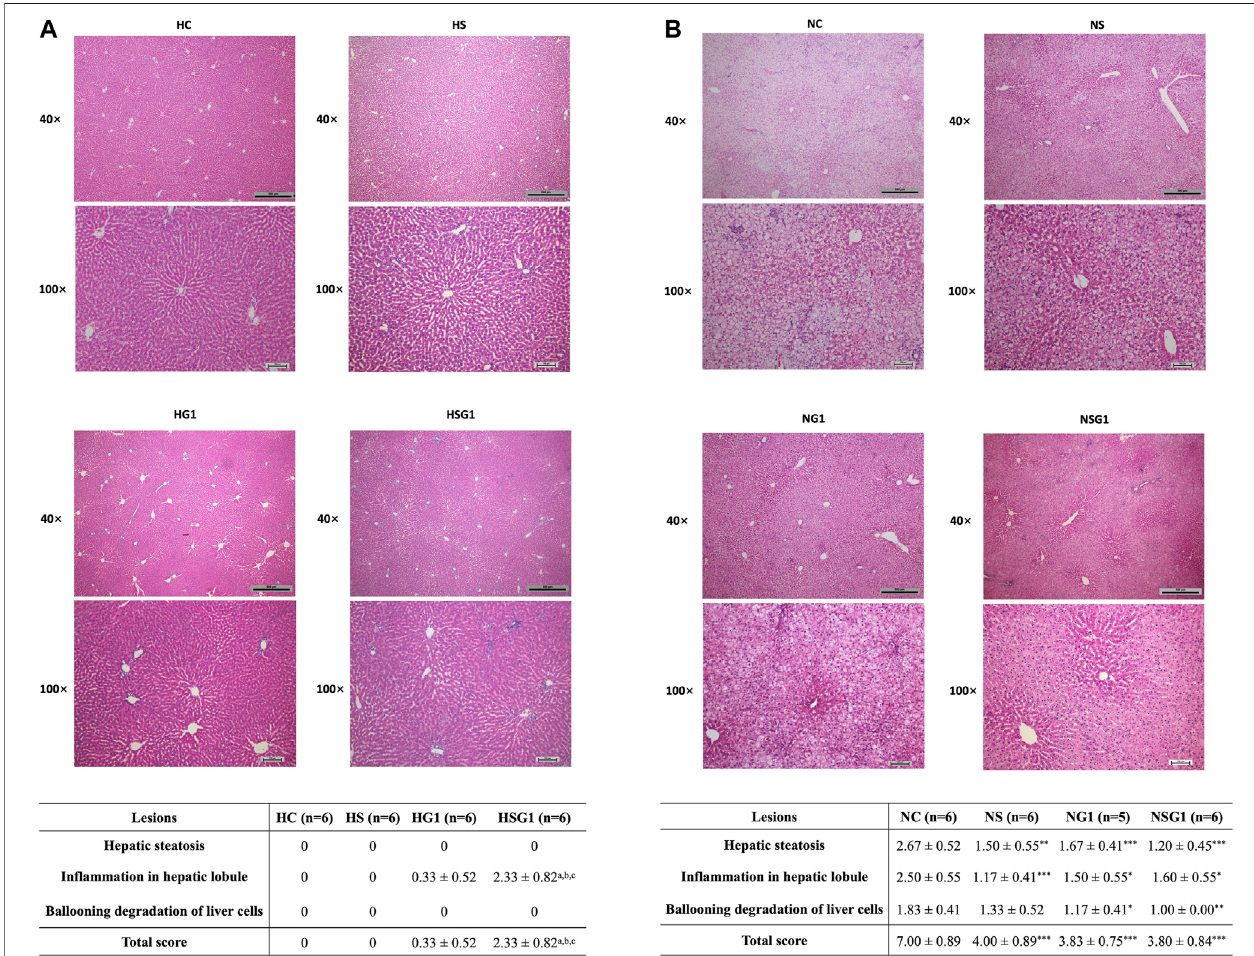
FIGURE6| HistologicalevaluationbyH&Estainingofliversfromhealthy (A) andNASH (B) ratswhichreceivedtwo-weekvehicle(HCandNC),SV(HSandNS),GJ (HG1 and NG1), and their combination treatment (HSG1 and NSG1) and their NAS-based semi-quanti fi cation. H and N denoted healthy and NASH, respectively. C, S, and G indicated that the rats received vehicle, SV, and GJ, respectively. a p < 0.001, b p < 0.001, and c p < 0.001 compared to the rats from groups HC, HS, and HG1, respectively. *** p < 0.001 compared to the rats from the NC group.